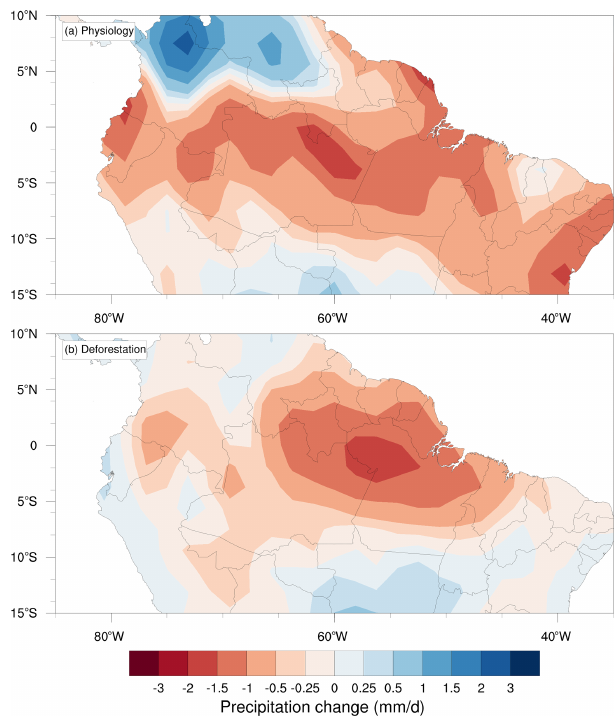
Figure 2. Annual mean precipitation changes relative to control simulations obtained using CPTEC-BAM in tropical South Amer- ica (a) under an atmospheric CO 2 concentration of + 200ppmv (1.5 × CO 2 ) affecting solely surface vegetation physiology (Physi- ology) and (b) with the complete substitution of the Amazon forest by pasture grasslands and a control CO 2 concentration of 388ppm